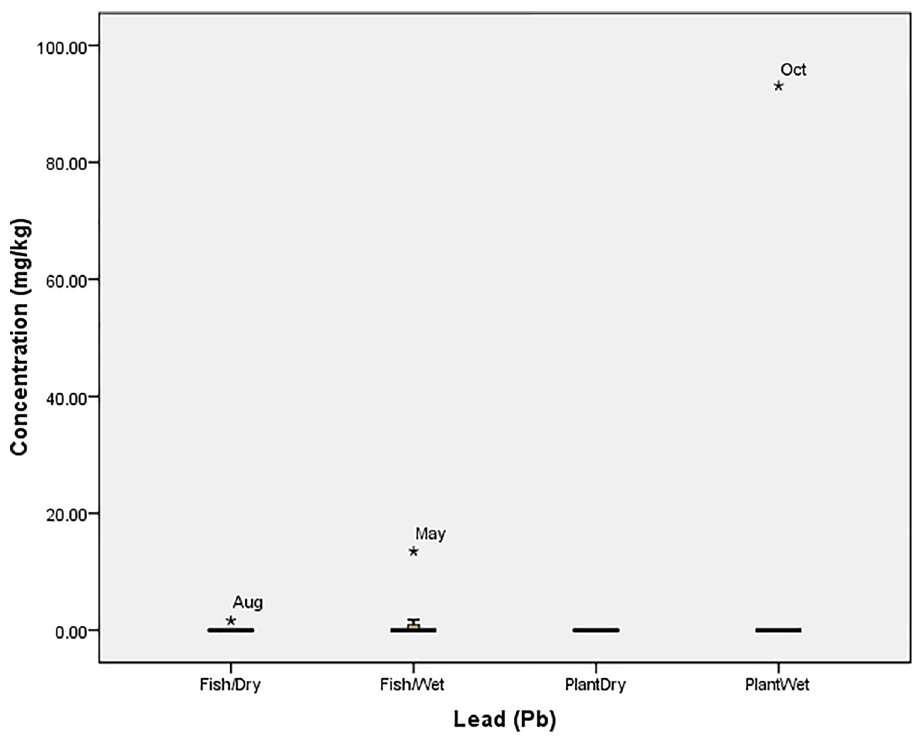
Figure 8. Tolerability of Lead (Pb) in O. niloticus (Fish) and I. aquatica (Plant) in Wet and Dry Seasons (Source: Field Survey).